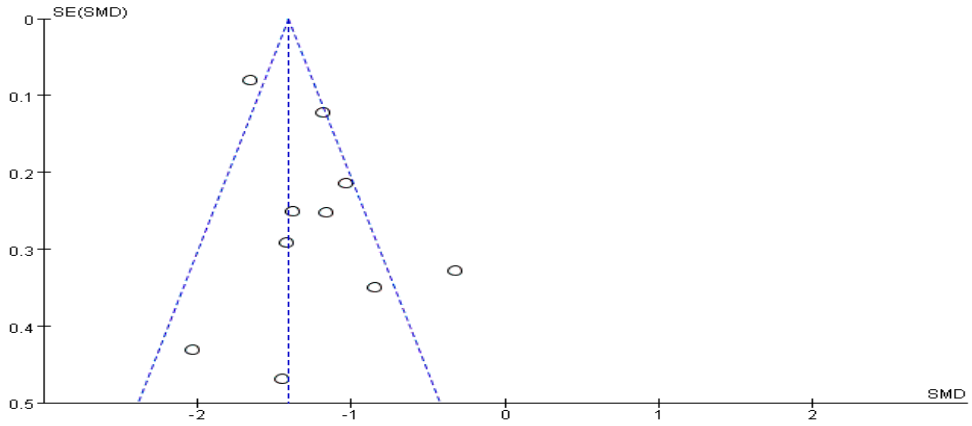
Figure 2. Effect of exercises on total score of smartphone addiction.